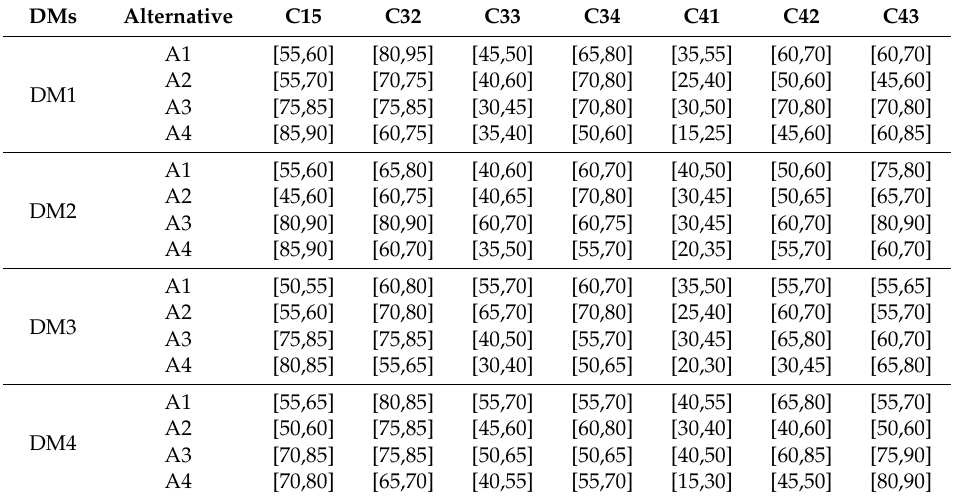
Table 5. The corresponding scores of the quantitative criteria which form are interval